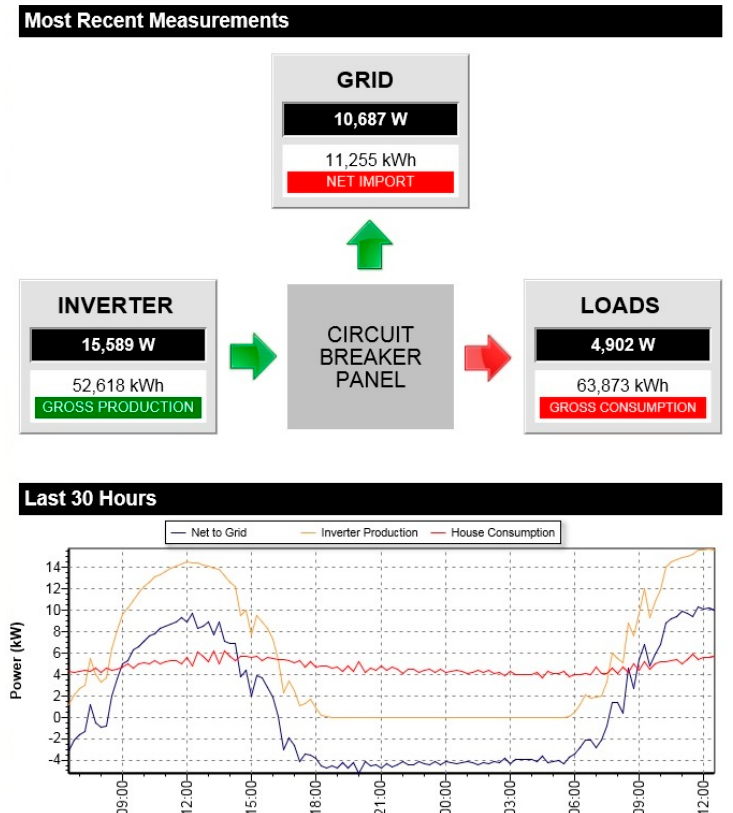
Figure 15. The load of the SQU Eco-House (Figure 14) during the summer and the amount of energy fed back to the grid.